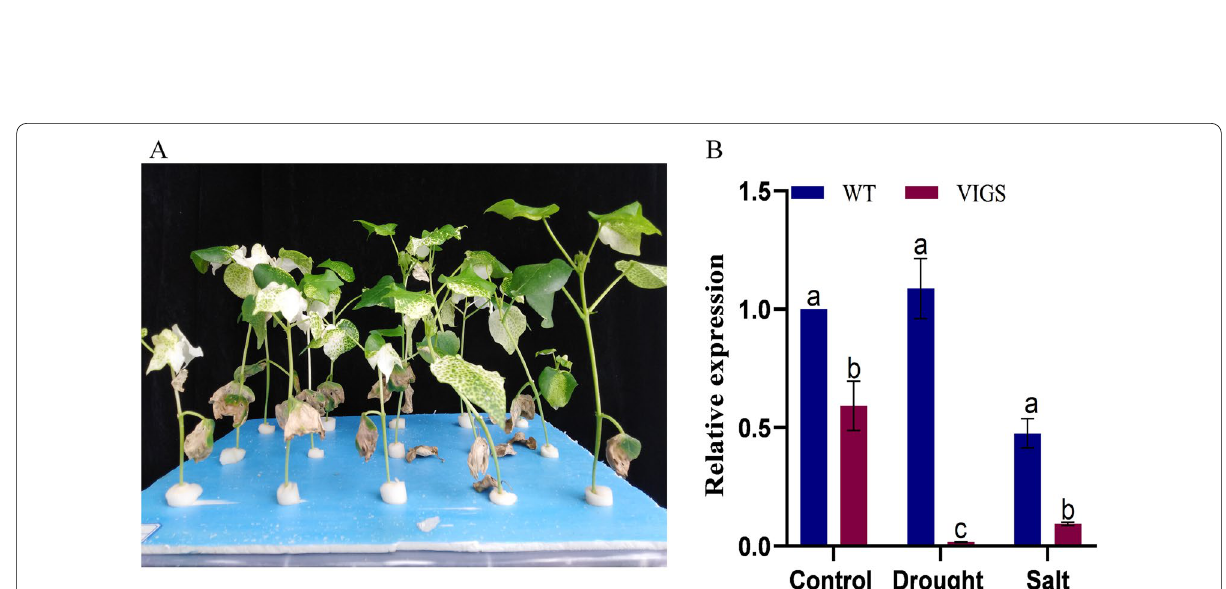
Fig. 7 The efficiency of virus-induced gene silencing in the cotton seedlings. A The albino change on the plants under being inoculated with TRV: PDS after 14 days. B Expression levels of the knocked gene in WT and VIGS-plants under normal conditions (control), drought and salt stress. Bar indicates the standard error (SE). Different letters indicate the significant differences between the wild type (WT) and the VIGS-plants (ANOVA; P <